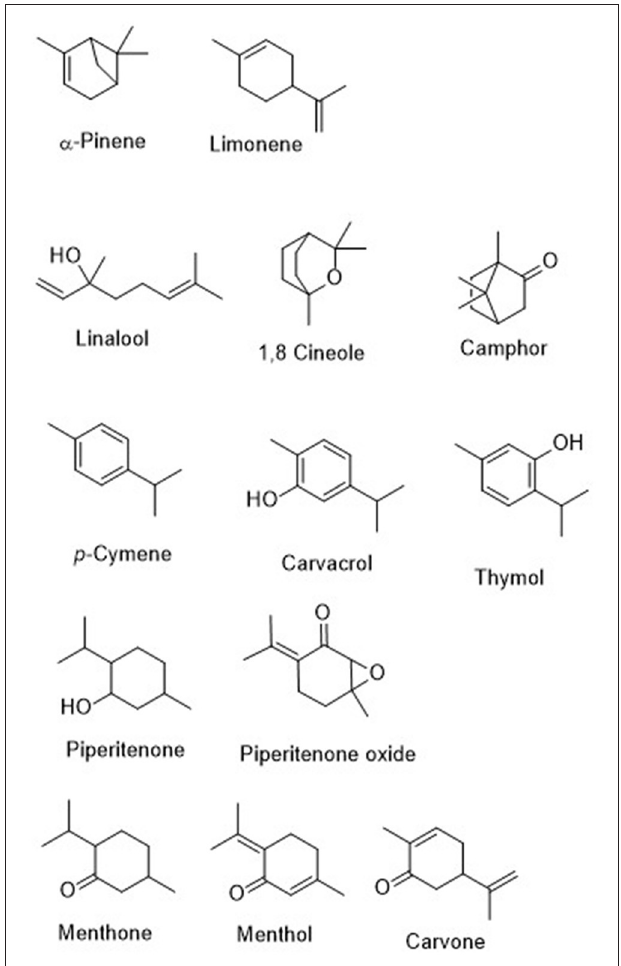
FIGURE 1 | Chemical structures of the essentail oils main